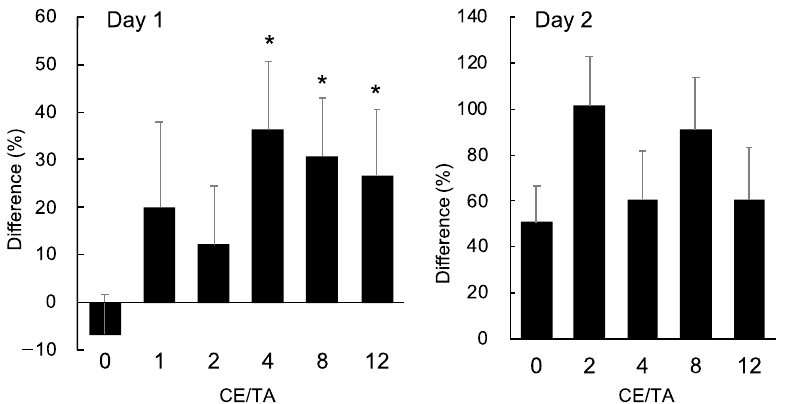
Figure 2. Effect of green tea ingestion on sucrose preference in LPS-injected mice in 1-day and 2-day experiments. Mice drank water or 1% sucrose ad libitum for 24 h. Difference (%) = [(sucrose intake after LPS injection/baseline value) − 1] × 100. Each value represents mean ± SEM ( n = 8). Asterisks indicate significant differences relative to control (CE/TA = 0) (* p < 0.05, Fisher’s least significant difference test).